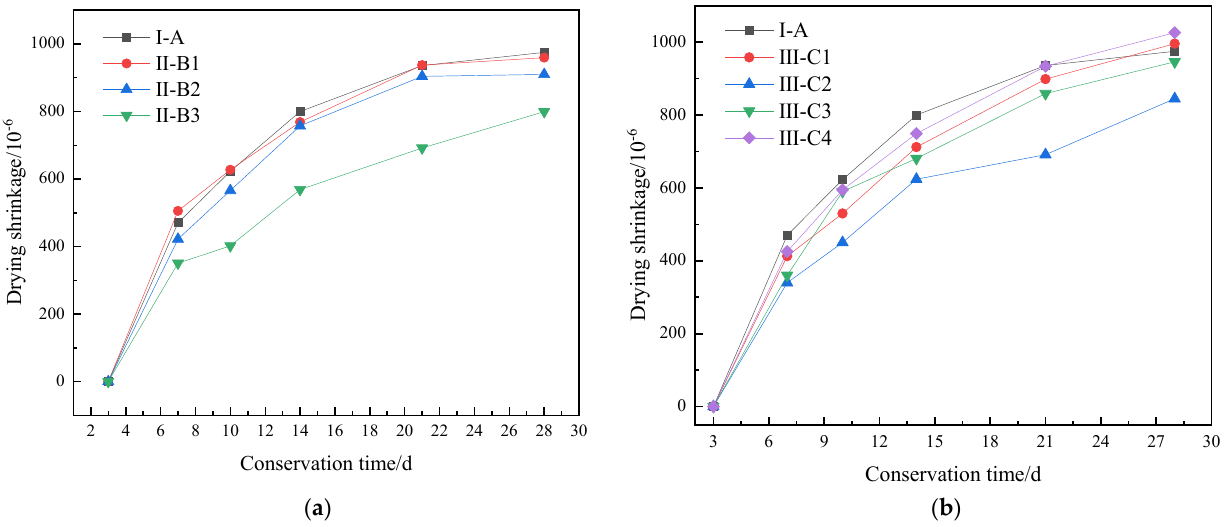
Figure 3. Effect of SAP on the drying shrinkage of the polymer mortar: ( a ) effect of single early-age strength component on drying shrinkage of mortar; ( b ) effect of compound early-age strength components on drying shrinkage of mortar.